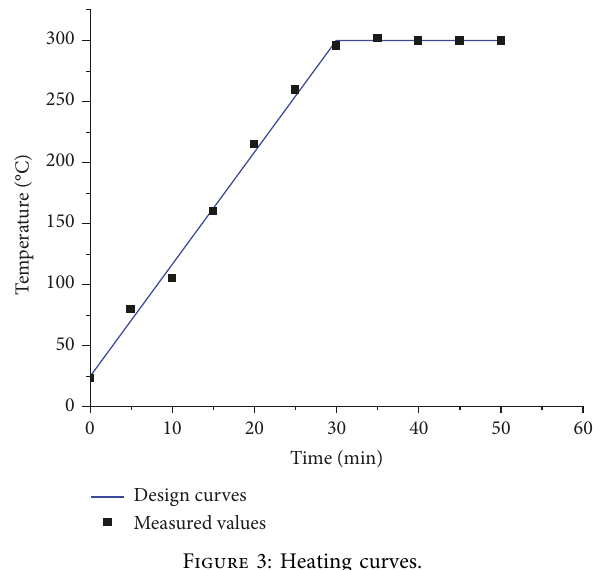
Figure 3: Heating